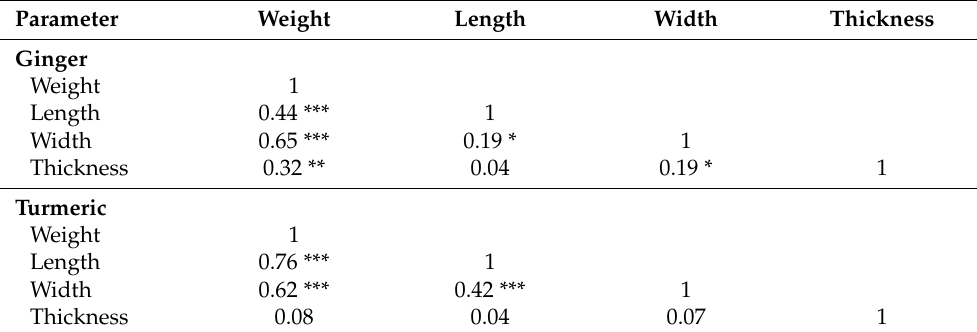
Table 4. Pearson correlation of the morphological parameters of ginger and turmeric seed rhizomes. Parameter Weight Length Width Thickness Ginger 1